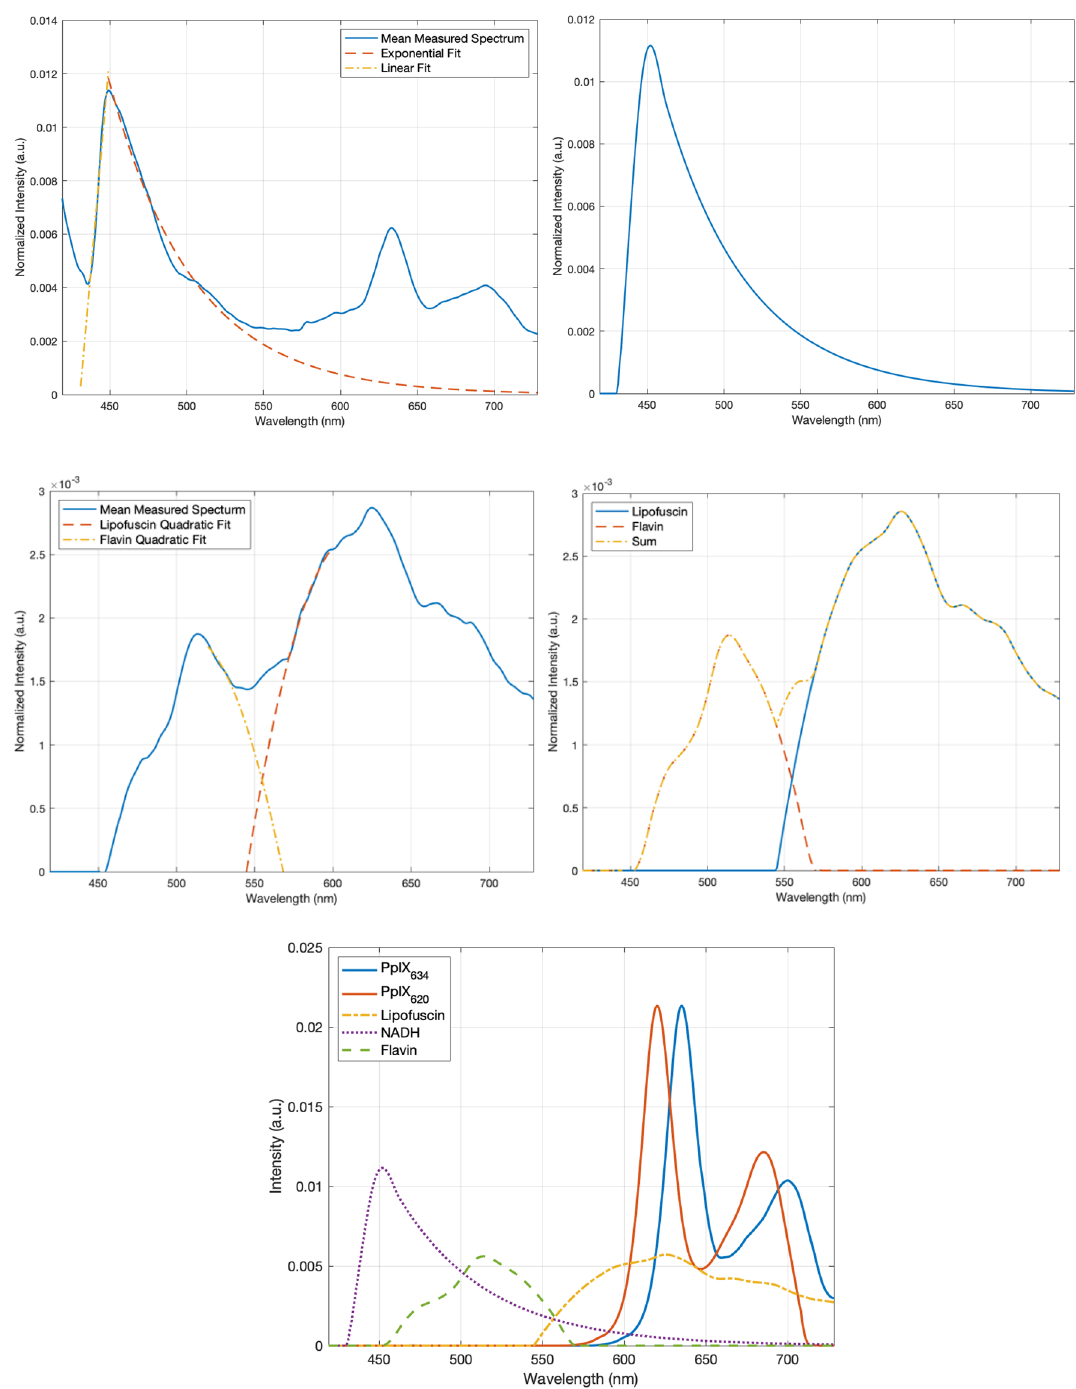
Figure 2. (Top) Mean spectrum containing the NADH spectral contribution with the expected NADH curves fitted (left) and the resultant NADH basis spectrum (right). (Middle) Lipofuscin and flavin spectra fitted to the mean measured spectrum (left) and the resulting basis spectra and their sum (right) which closely matches the mean measured spectrum. (Bottom) The resulting 5 basis spectra from this